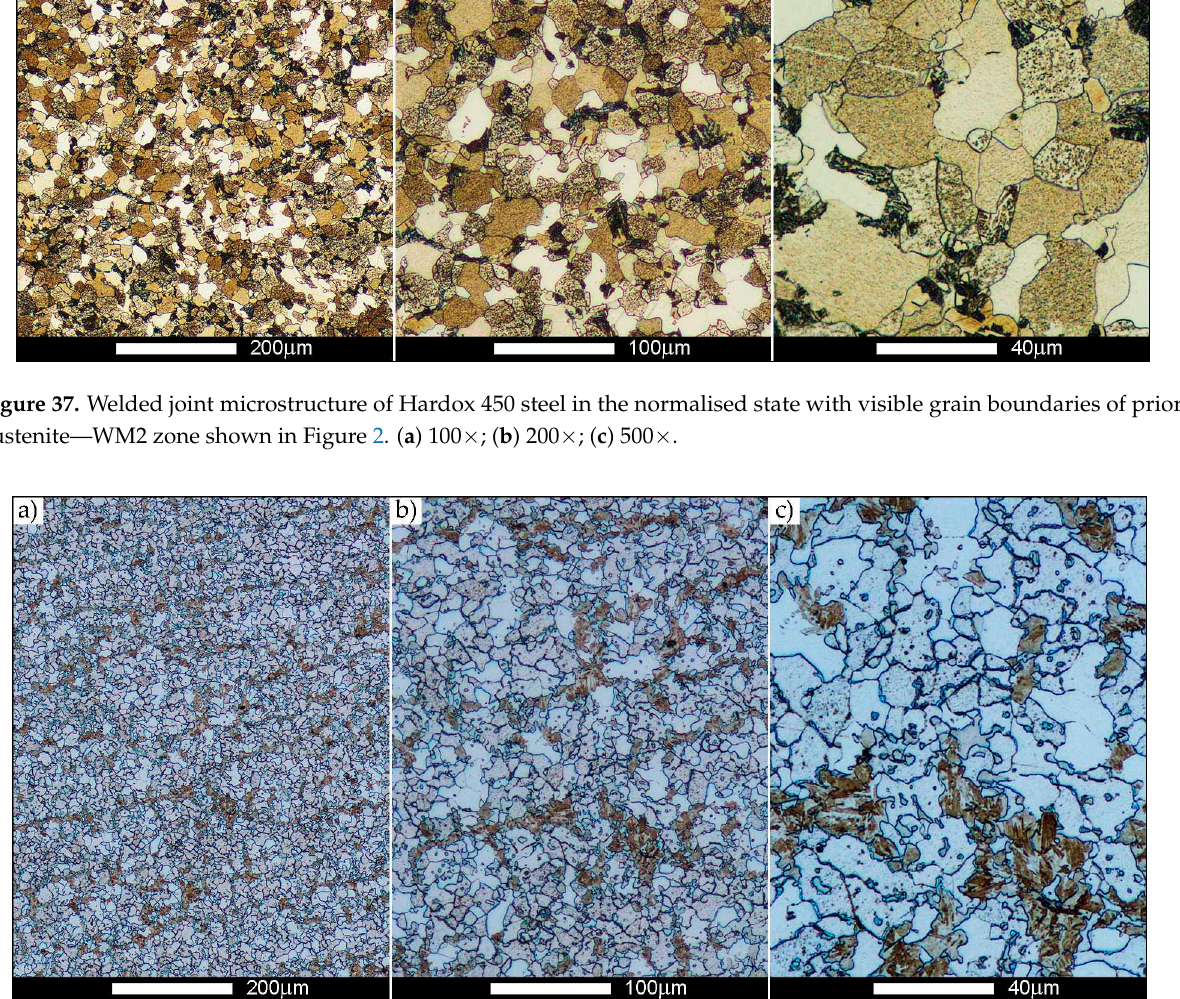
Figure 38. Welded joint microstructure of Hardox 450 steel with visible prior austenite grain boundaries, austenitised at 900 °C—WM2 zone shown in Figure 2. ( a ) 100×; ( b ) 200×; ( c ) 500×.